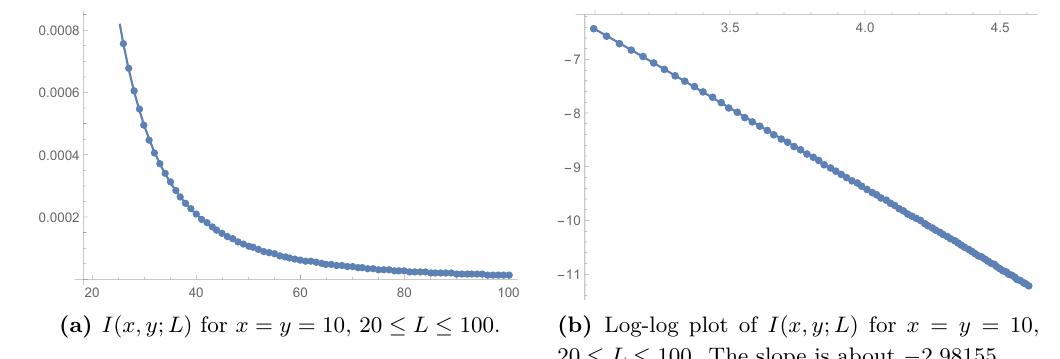
Figure 11 . The mutual information for the fixed size of H H . We fix x and y = 2 L − x − d − 2 , and change the cutoff size L (a) is I ( x, y ; L ) for x = y = 10 , 20 ≤ L ≤ 100 . (The horizontal axis is L .) (b) is the log-log plot for the same quantity. (The horizontal axis is log L .) The slope is approximately − 2 . 9816 . The other parameters are R = 1 and µ = 10